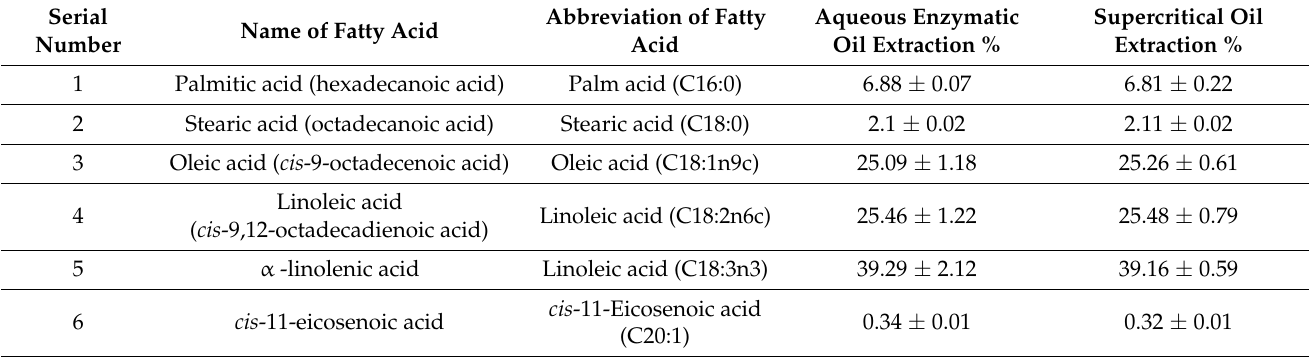
Table 7. Comparison of the fatty acid content peony seed oil extracted using different methods.